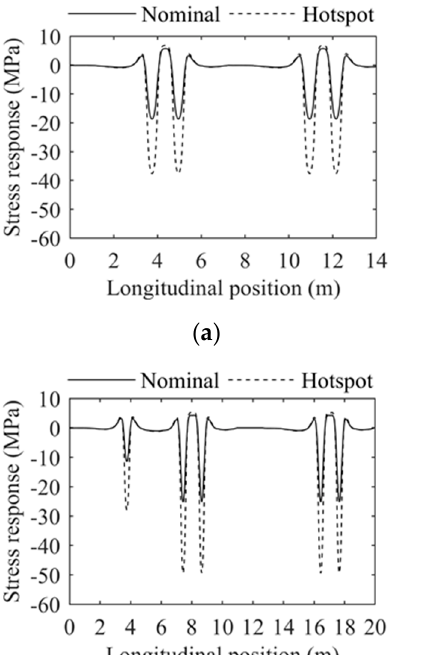
Figure 11. Unitised influence surface of joint U12 L : ( a ) Nominal stress; ( b ) Hot spot stress.